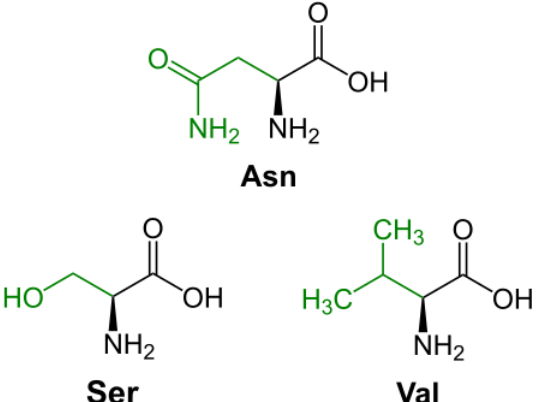
Scheme 1. Structural formulas of the three neutral amino acids used in the current study. The sidechains are highlighted in green for asparagine (Asn, top ), serine (Ser, bottom left ) and valine (Val, bottom right ). All amino acid monomers shown here are the S enantiomers.